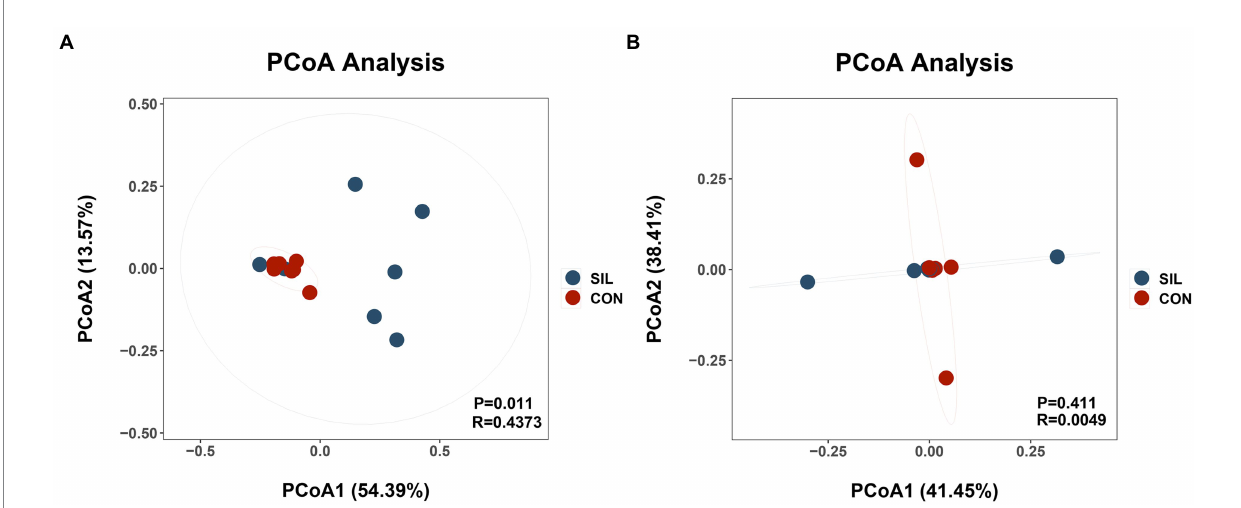
FIGURE 2 Beta diversity of the microbial communities in the rumen digesta of lambs in the CON and SIL groups. Principal coordinate analysis (PCoA) of weighted UniFrac distance metric of rumen (A) and ileum (B) . CON = supplemented with 10% soybean meal; SIL = supplemented with 10% silybum marianum meal. p < 0.05 was regarded as statistically